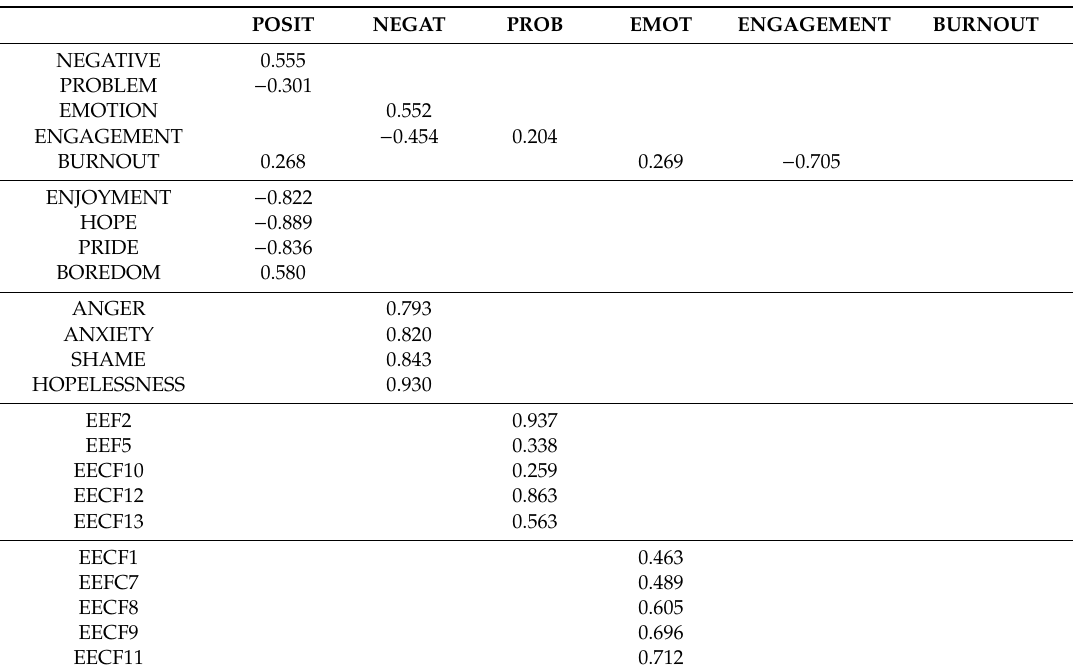
Table 7. Standardized Direct E ff ects (Default model): Study